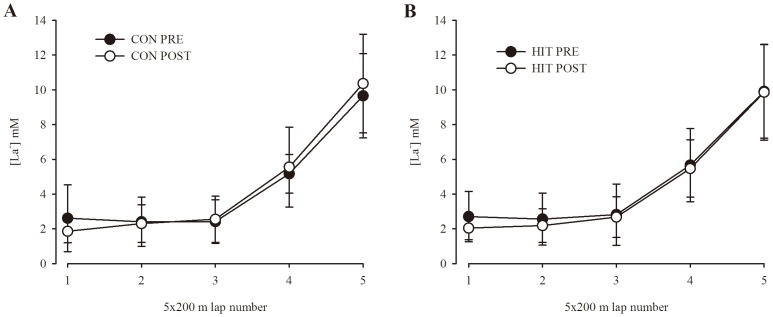
Blood lactate.Blood lactate determined from a finger capillary sample obtained 1 minute after each of five 200(see methods) in two groups of swimmers before (PRE) and after (POST) a training intervention. One group performed usual swim-training (CON) and another group reduced their training volume by 50% and more than doubled the amount of high-intensity training (HIT).